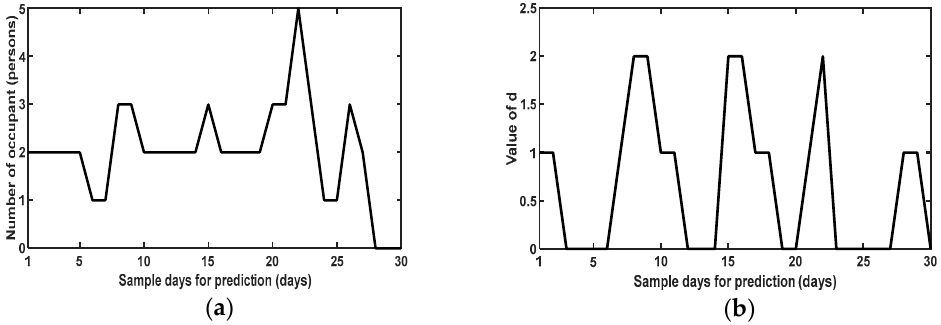
Figure 8. ( a ) Occupant data and ( b ) day type data used for all the methods during prediction.